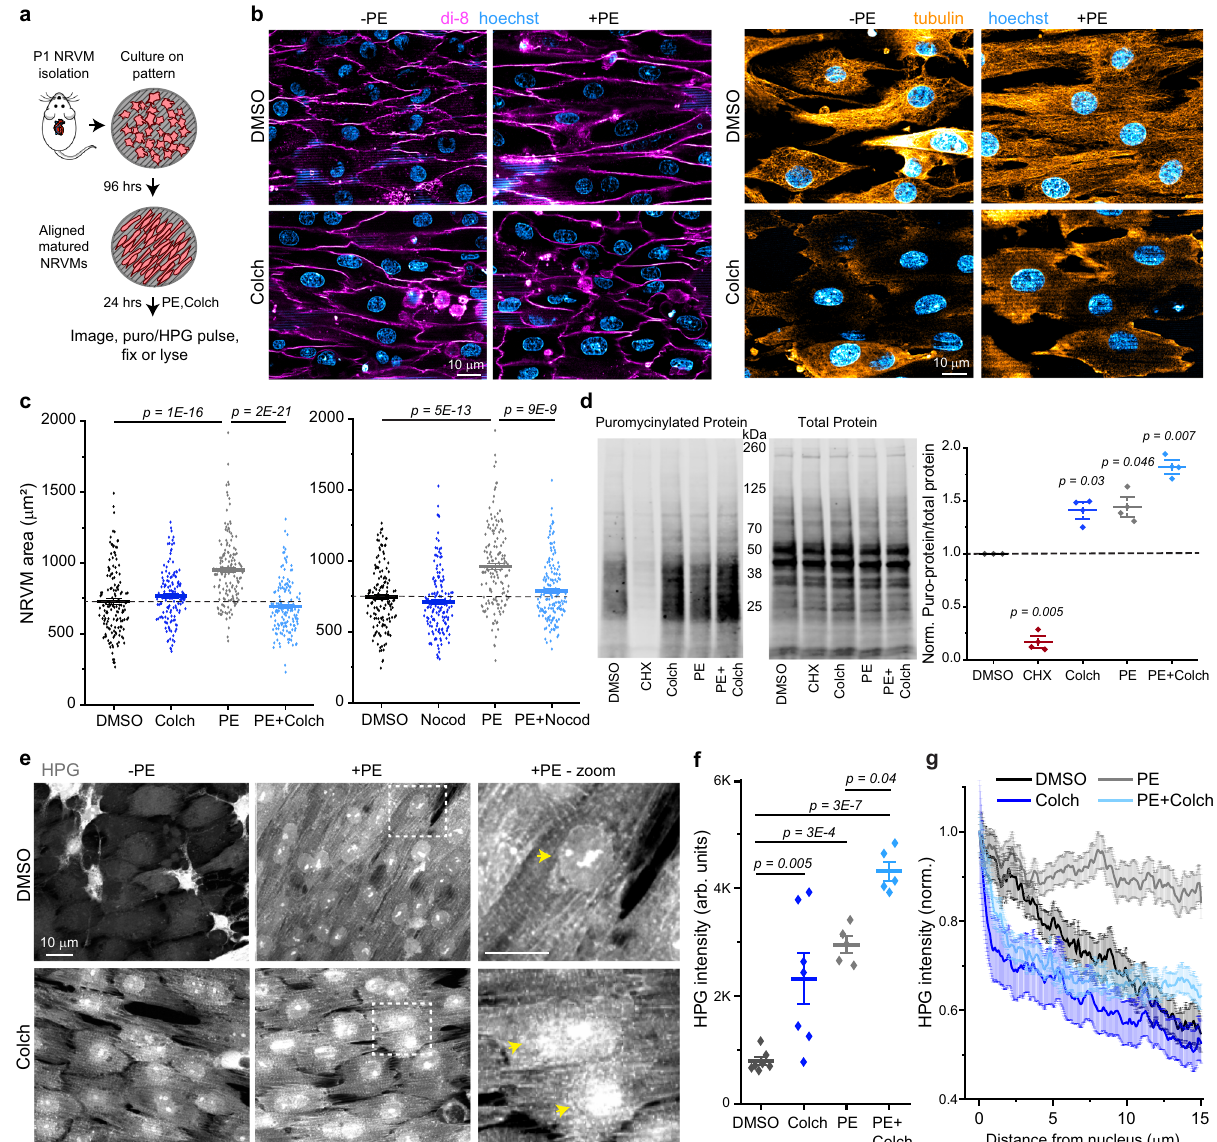
Fig. 2 Microtubule depolymerization leads to mislocalized translation. a Experimental design of NRVM isolation, patterning, and experiments. b Representative live-cell (left) or immuno fl uorescence (right) images of NRVMs treated with DMSO, PE, Colch, or PE + Colch. c Quanti fi cation of cell areas in NRVMs treated with (left) DMSO ( n = 147), PE ( n = 148), Colch ( n = 138), or PE + Colch ( n = 143) and (right) in NRVMs treated with DMSO ( n = 145), PE ( n = 148), Nocod ( n = 150), or PE + Nocod ( n = 151). Statistical signi fi cance determined via one-way ANOVA with post hoc Bonferroni comparison, each treatment repeated in at least 3 independent NRVM litters. d Measurement of translational activity in NRVMs. Representative western blots labeled for puromycinylated proteins (left) and total protein (center). (right) Quanti fi cation of translation rate, normalized to DMSO. One-sample, two-tailed t -test vs. mean = 1, unadjusted p -value reported. e Representative fl uorescence images of NRVMs treated with DMSO, PE, Colch, or PE + Colch. Yellow arrows indicate nuclei. f Quanti fi cation of HPG intensity. DMSO ( n = 137 NRVMs), PE ( n = 126), Colch ( n = 132), or PE + Colch ( n = 140), each data point represents pooled single-cell values from a fi eld of view, statistical signi fi cance determined via one-way ANOVA with post hoc Bonferroni comparison. g Averaged line scans of HPG intensity. DMSO ( n = 30 NRVMs), PE ( n = 30), Colch ( n = 30), or PE + Colch ( n = 30). For all graphs shown in fi gure, the mean line is shown, with whiskers denoting standard error (SE) from the mean. Source data are provided as a Source data fi